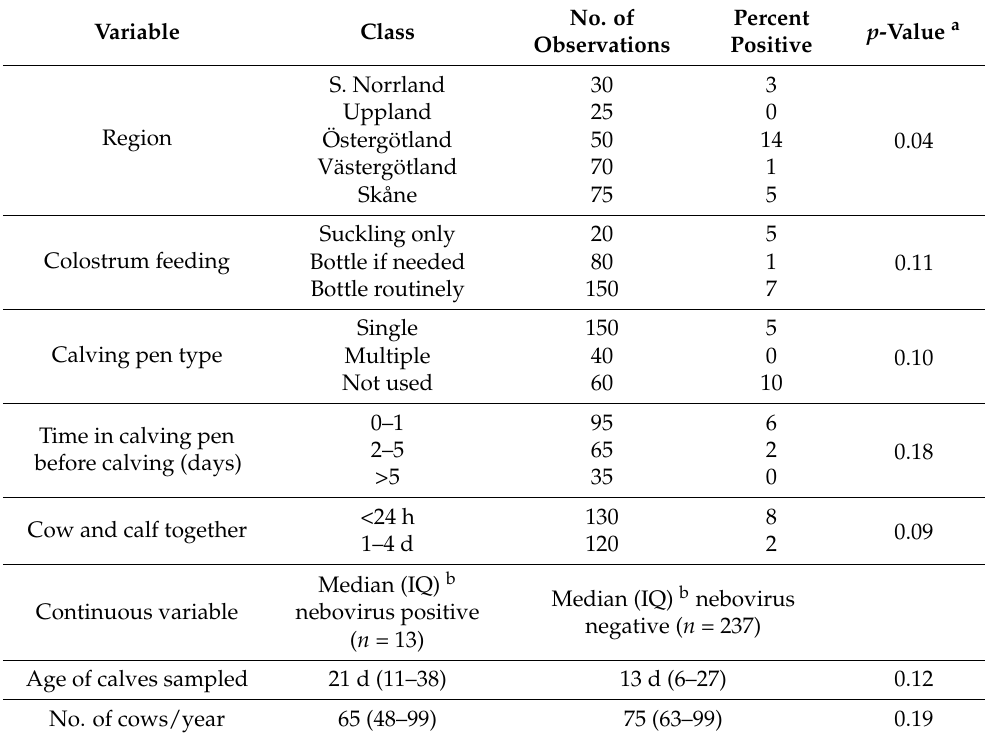
Table 3. Factors univariably associated ( p < 0.2) with nebovirus shedding detected by RT-PCR in 250 preweaned calves and offered to the multivariable regression